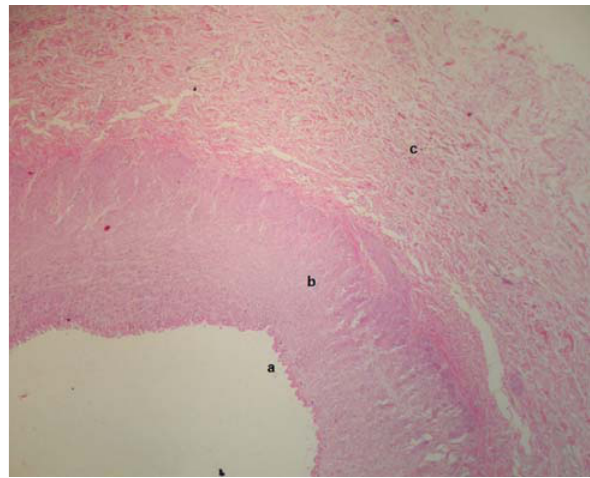
Fig. 5 - Corte transversal da artéria renal em frente ao stent: (a) camada íntima, (b) camada muscular média, (c) camada